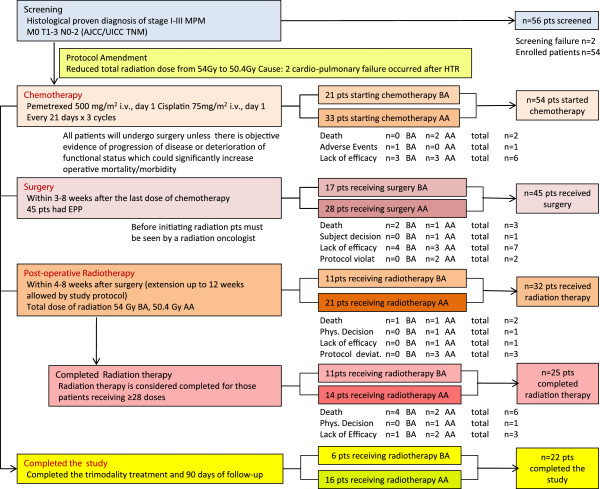
Study design and patients disposition adopted in this study. Study design highlights the trimodality therapy adopted: patients disposition is provided for patients enrolled before the protocol amendment (PA) as well as for those enrolled after PA and overall. Trimodality therapy was considered completed for those patients who received ≥28 doses of radiotherapy (RT) while the study was considered completed for those subjects completing RT and the 90-day post-radiation follow-up. pts = patients; MPM = malignant pleural mesothelioma; HTR = hemithoracic radiation; EPP = extrapleural pneumonectomy; BA = before amendment; AA = post amendment.